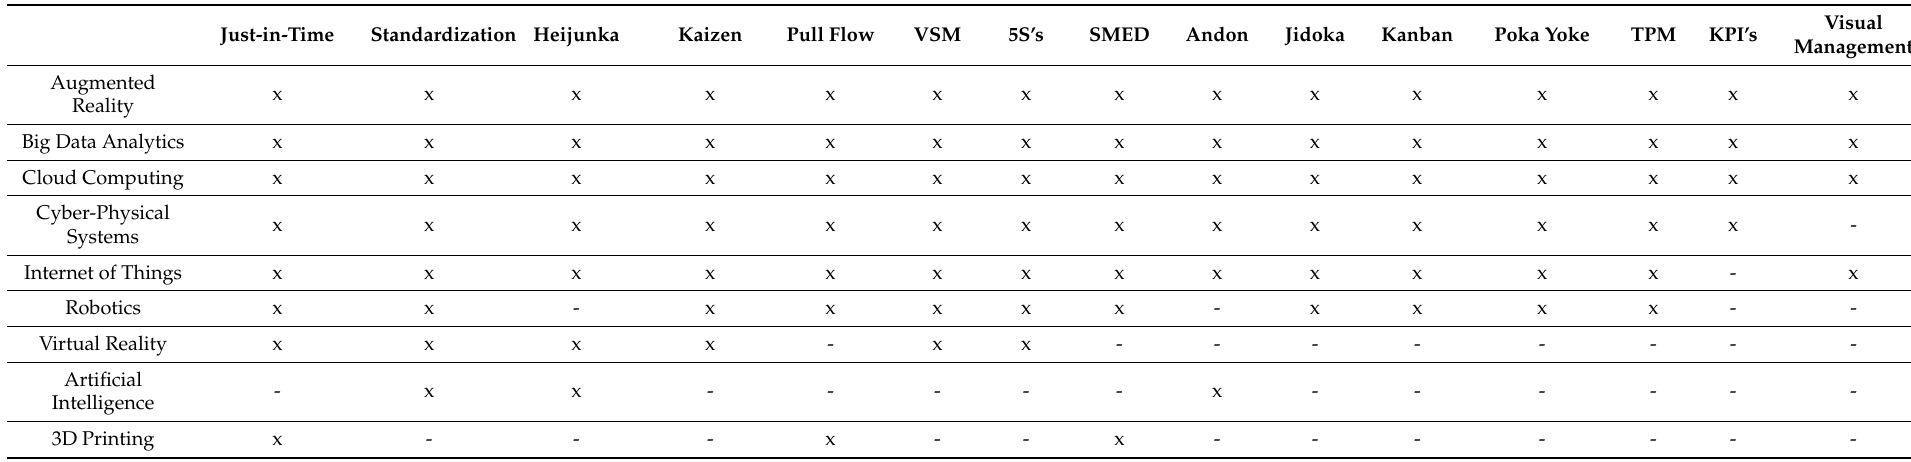
Table 6. I4.0 vs. lean matrix: The contributions of I4.0 technologies on the lean